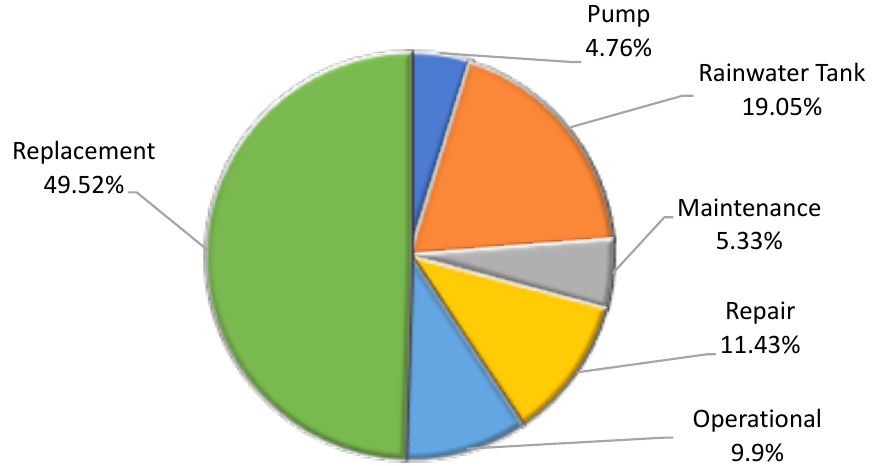
Figure 13. Breakdown of life cycle cost.